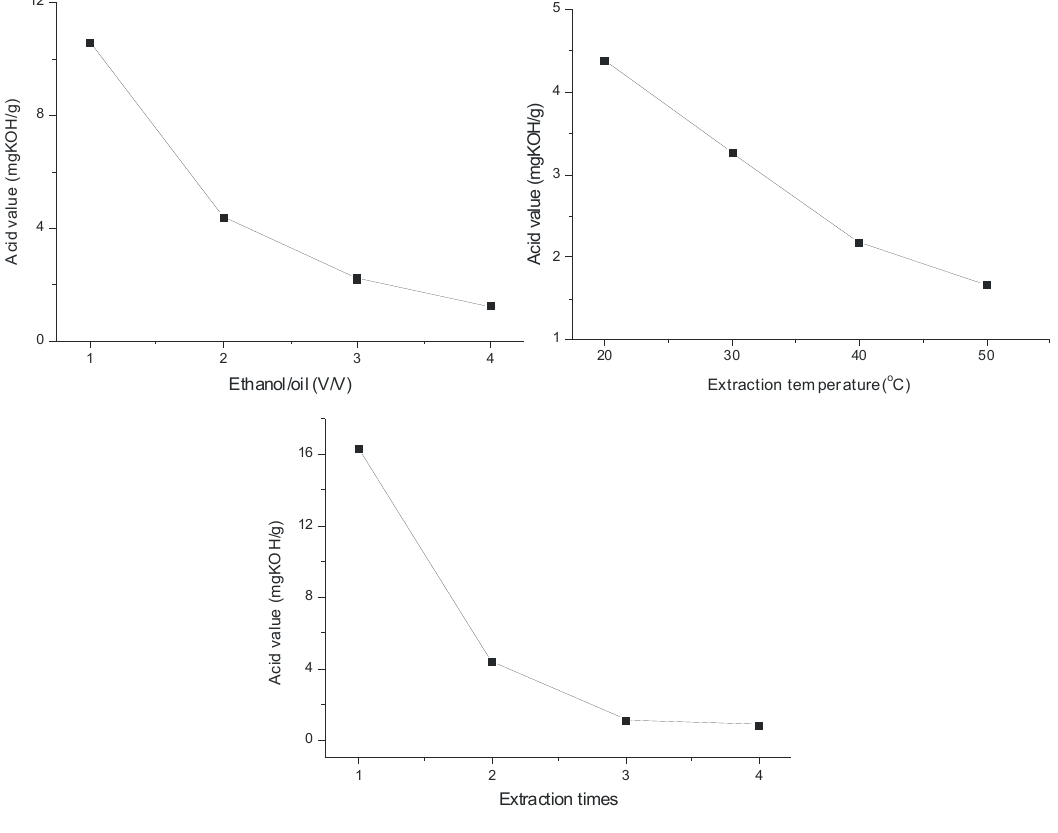
Figure 1. Single factor experiments of Pistacia chinensis oil deacidification with